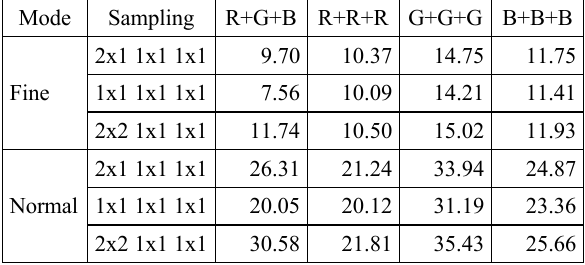
Table 2. Compression ratio of the image shown in Figure 2 Table 2 indicate that the difference of the downsampling factors would not produce a greater difference of compression ratios than the difference of the quantization tables utilized in quantization of DCT-coefficient data between the two modes: Fine and Normal of EOS 20D.